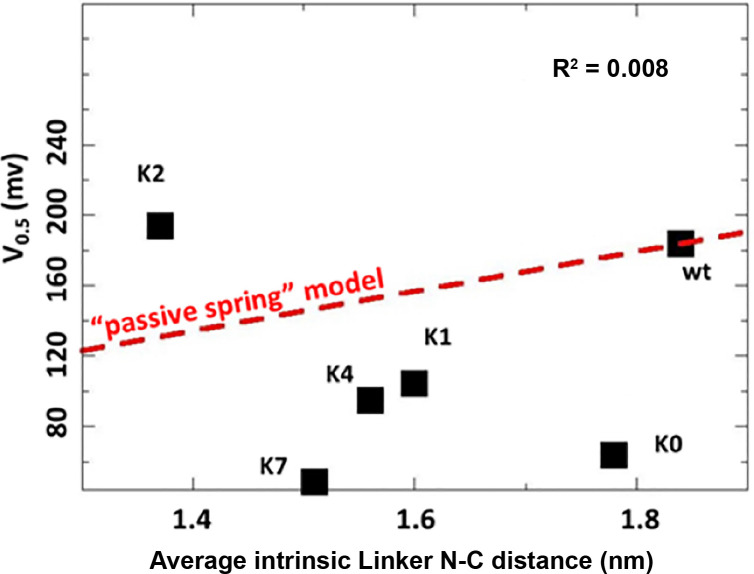
Correlation between the average intrinsic end-to-end distance of free C-linkers and measured V0.5 of the WT hSlo1 and mutants.The average distances were calculated from ABSINTH simulations of isolated C-linker peptides. The red dashed line shows the linear relationship derived from the C-linker insertion/deletion study (Niu et al., 2004; also see Table S1).